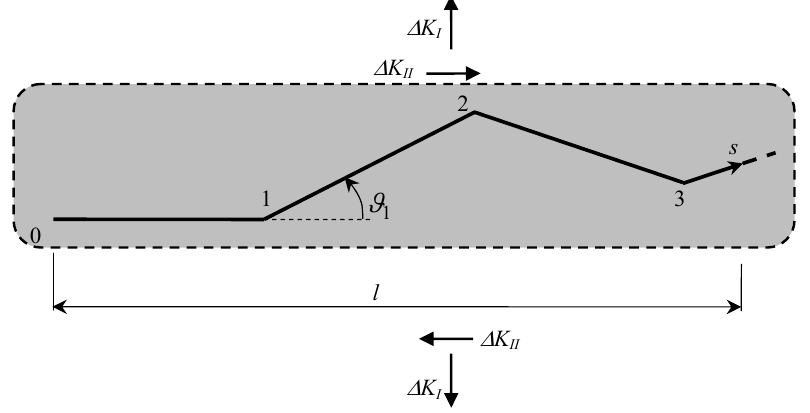
Figure 4: Fatigue growth of the kinked